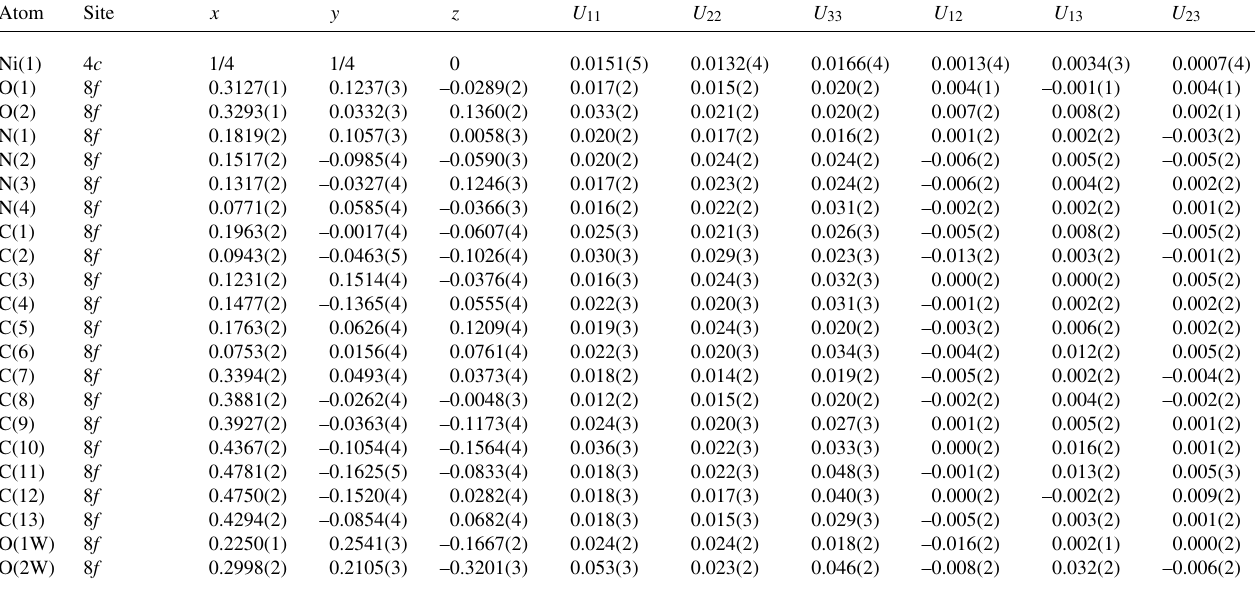
Table 3. Atomic coordinates and displacement parameters (in Å 2 ) .